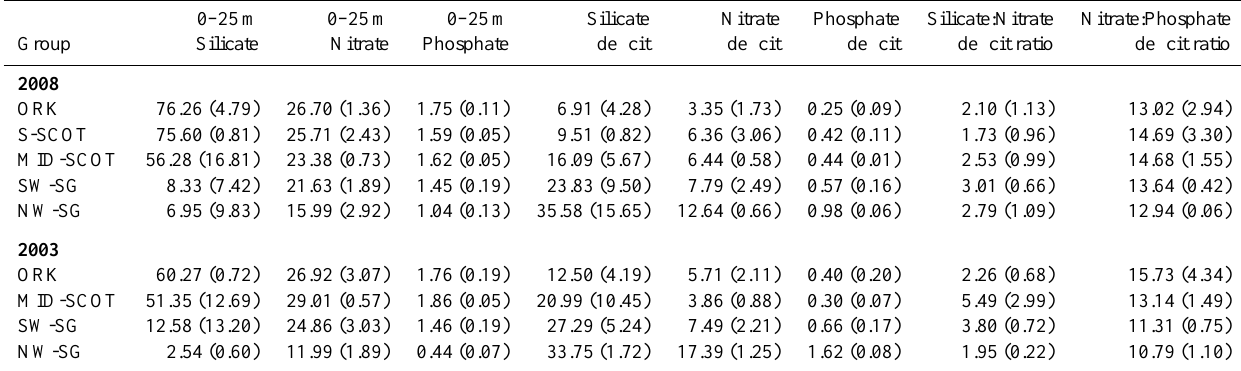
Table 5. Station group averages and standard deviations for surface (0–25m) macronutrient concentrations (mmolm − 3 ) , deficits (winter water minus surface values) and deficit ratios for the 2003 and 2008 cruises. 0–25m 0–25m 0–25m Silicate Nitrate Phosphate Silicate:Nitrate